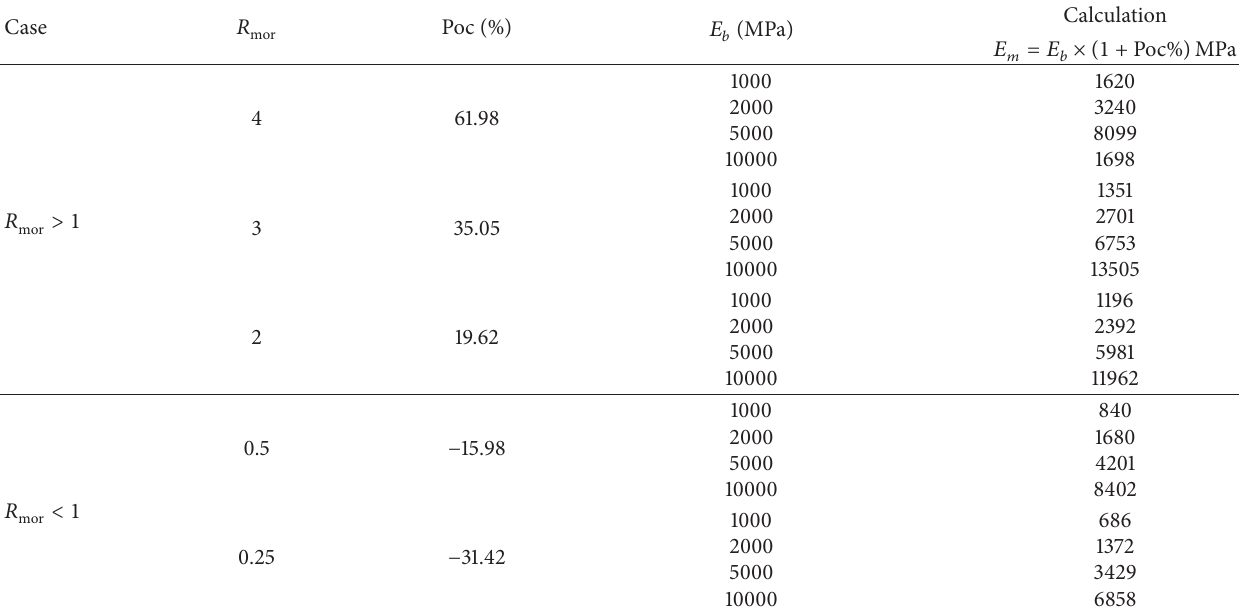
Table 5: Examples of the calculations 𝐸 𝑚